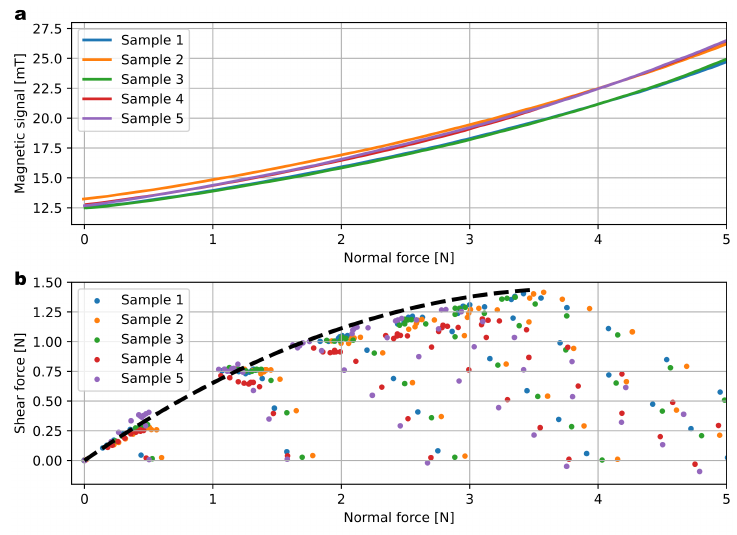
Figure 7. Response to applied forces. ( a ) Magnetic response to normal applied force for 5 samples, demonstrating the achieved consistency among the fabricated sensors. ( b ) Scatter plot of the shear force vs. normal force applied, demonstrating the consistency of the friction